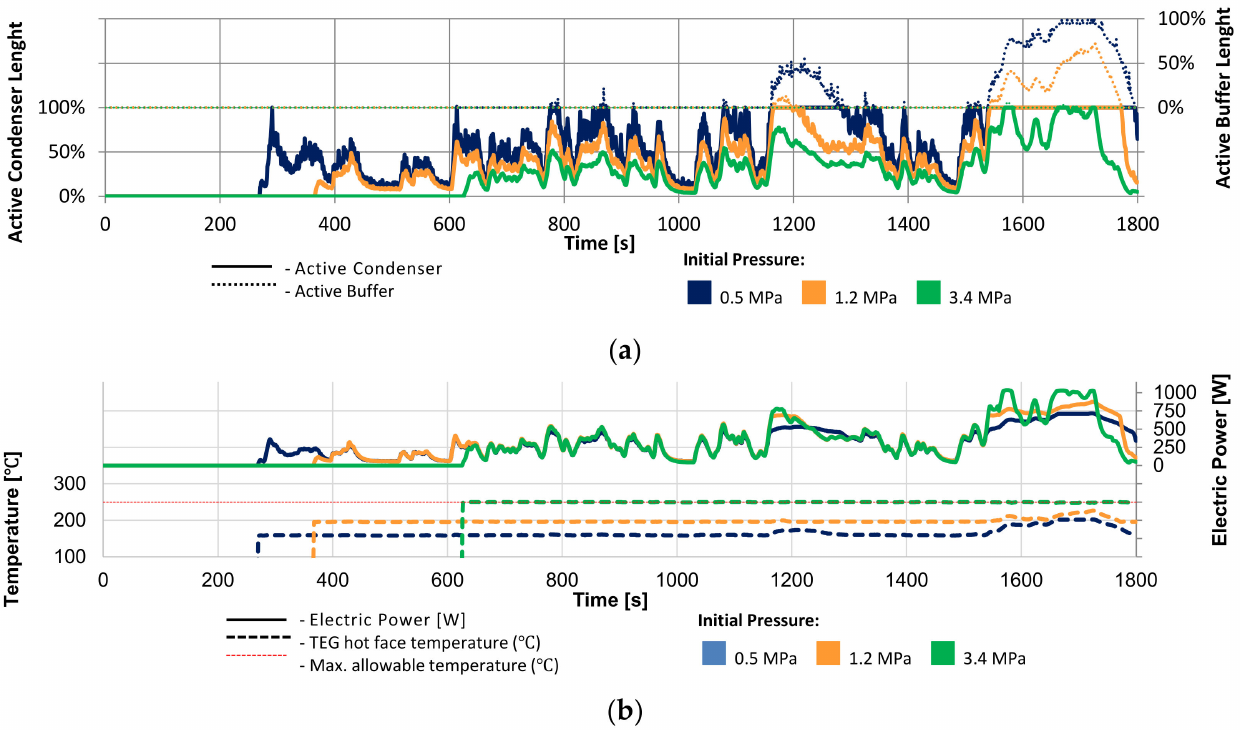
Figure 11. Effect of the pre-charge pressure on: ( a ) active condenser length percentage, ( b ) inner temperature and electric power (adapted from